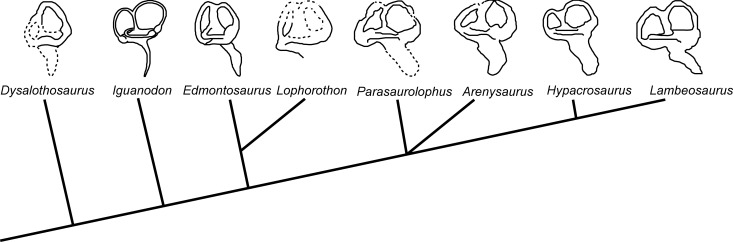
Endosseous labyrinths of the inner ears.Endosseous labyrinths of the inner ears redrawn for: Dysalotosaurus, Lautenschlager & Hübner, (2013; Fig. 2(h)); Iguanodon, Norman, Witmer & Weishampel (2004; Fig. 19.9); Edmontosaurus, Ostrom; (1961; Fig. 59a); Lophorhothon, Langston (1960; Fig. 163a); Parasaurolophus, Farke et al. (2013; Fig. 16d); Hypacrosaurus and Lambeosaurus, Evans, Ridgely & Witmer; (2009; Fig. 8a,e) and Arenysaurus ardevoli, displayed on a cladogram redrawn from Horner, Weishampel & Forster (2004), with additional data from McDonald (2012) and Cruzado-Caballero et al. (2013). Left inner ear: Edmontosaurus, Arenysaurus, Hypacrosaurus and Lambeosaurus; right inner ear: Dysalotosaurus, Iguanodon, Lophorhothon and Parasaurolophus.